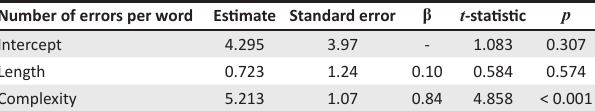
TABLE 2: Linear regression: Real word errors predicted. Number of errors per word Estimate Standard error